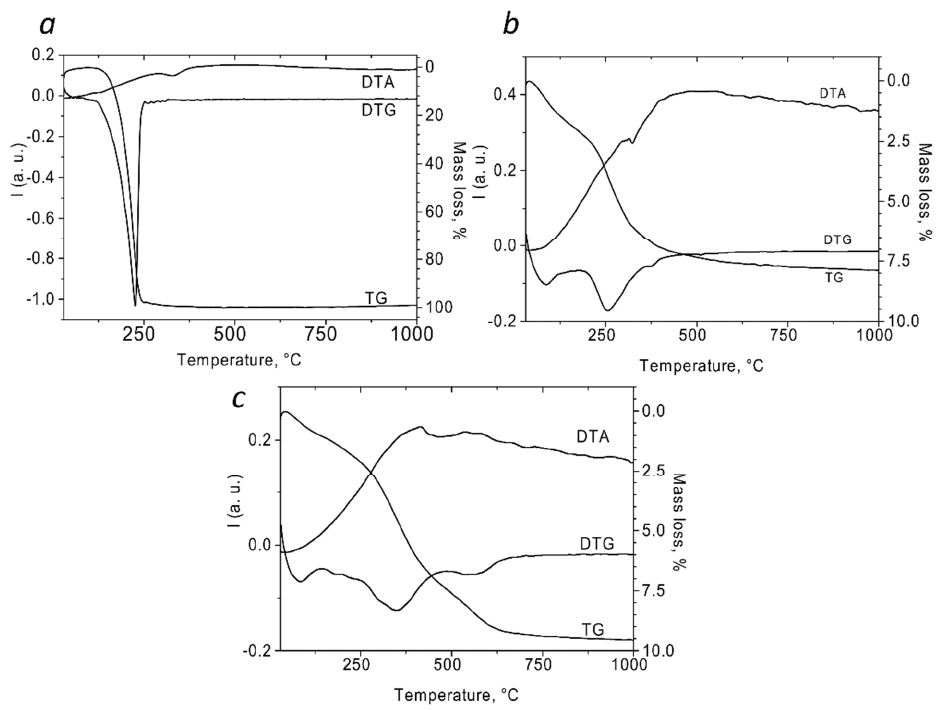
Figure 6. TG ‐ , DTG ‐ , and DTA ‐ curves for ( a ) lactide, ( b ) Silochrom/PLA and ( c ) Silochrom ‐ Figure 6. TG-, DTG-, and DTA-curves for ( a ) lactide, ( b ) Silochrom/PLA and ( c ) Silochrom- NH 2 /PLA. NH 2